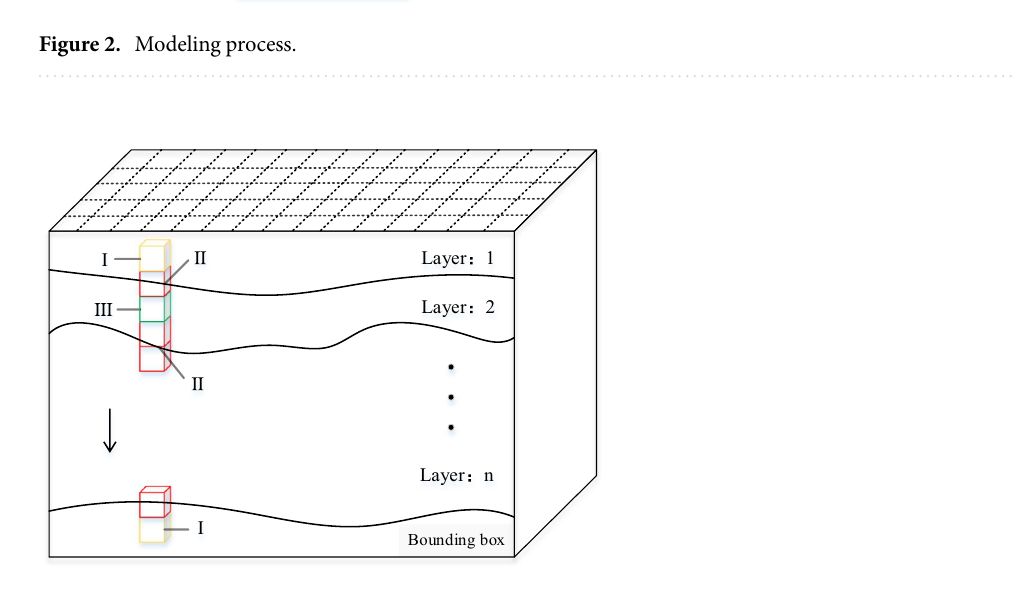
Figure 3. Schematic diagram of voxel